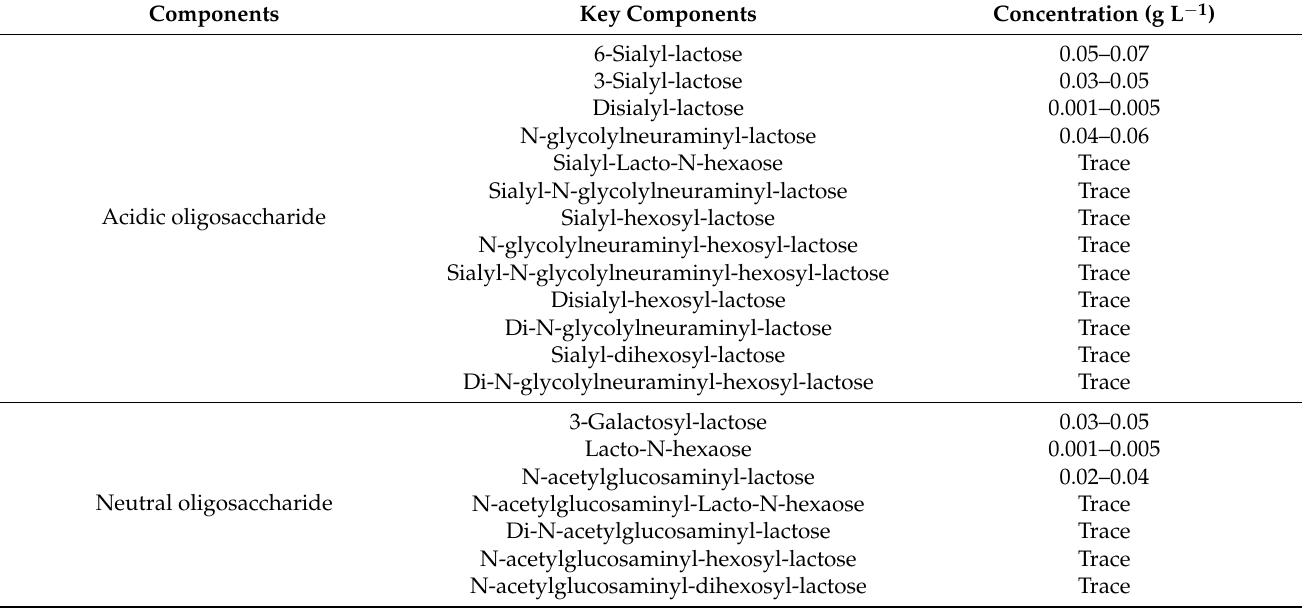
Table 4. Major oligosaccharide components are present in goat milk. Source: [99].